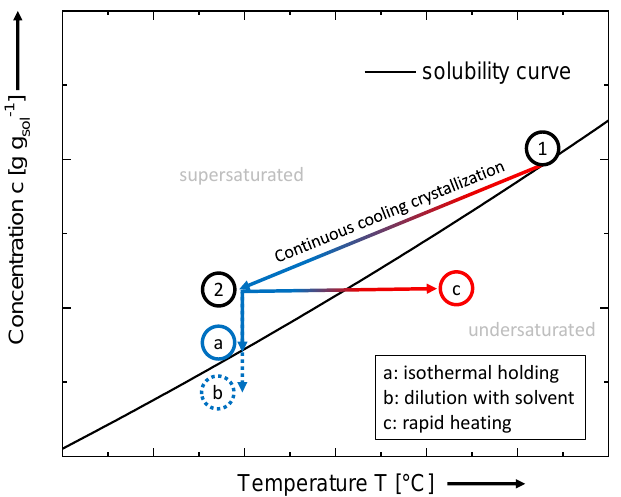
Figure 1. Concepts to realize degradation of supersaturation in continuous cooling crystallization. Point 1 is the start of the crystallization (nucleation) and Point 2 is the end of the continuous crystallizer.